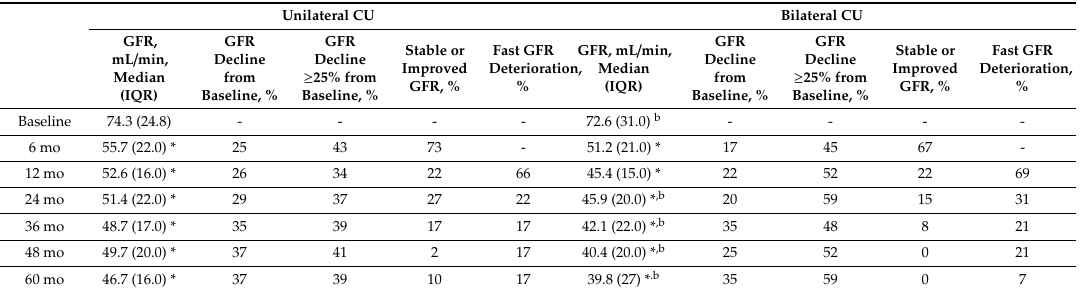
Stableor FastGFR Improved